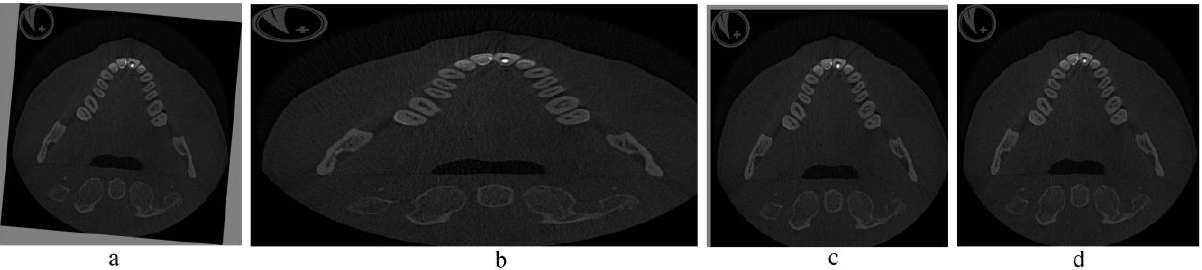
Figure 4. Examples of attacks: a rotation, b scaling, c translation, d